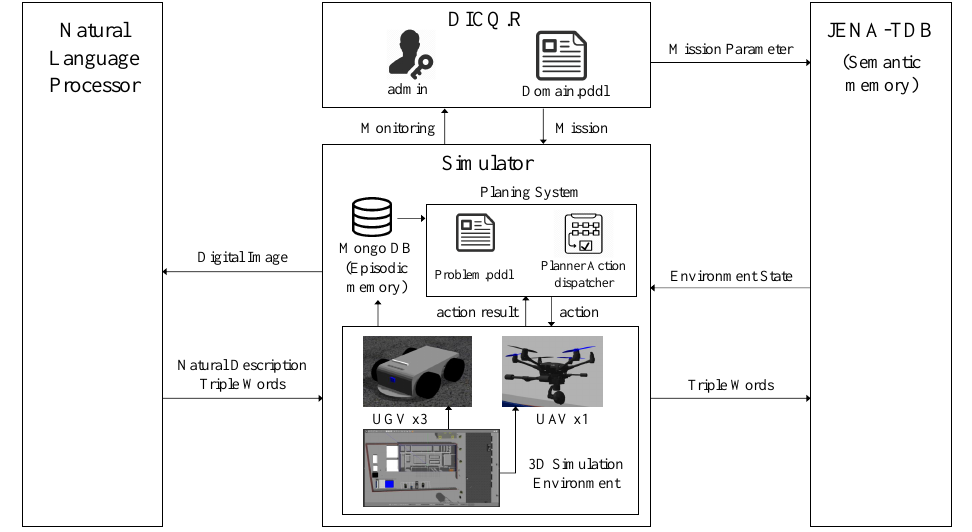
Figure 5. Operational diagram for the proposed method: It consists of a control tower, natural language processor, simulator, and JENA-TDB. Planning and execution are performed by the simulator. Natural language-based scene understanding is processed in the natural language processor. JENA-TDB is used as the semantic information